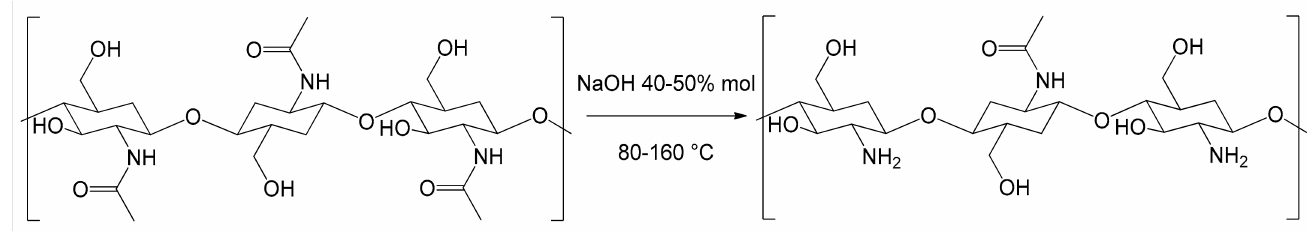
Figure 18. Synthesis of chitosan by partial deacetylation of chitin.